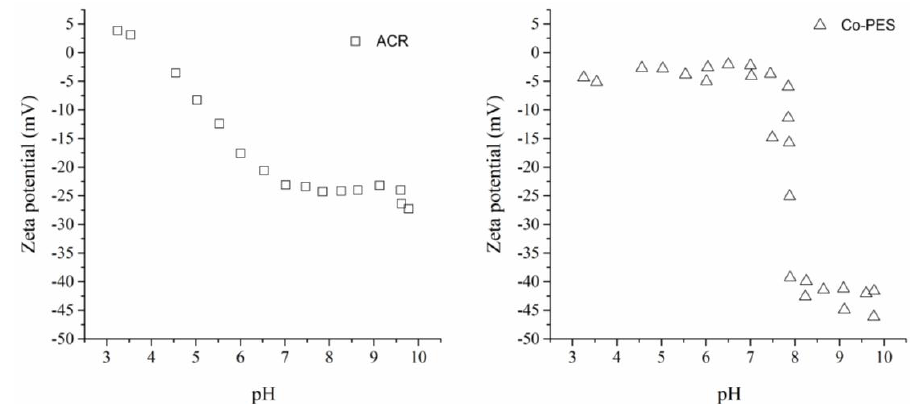
Figure 6. Zeta potential pH dependence of ACR dispersion ( squares ) and Co-PES dispersion ( triangles ).